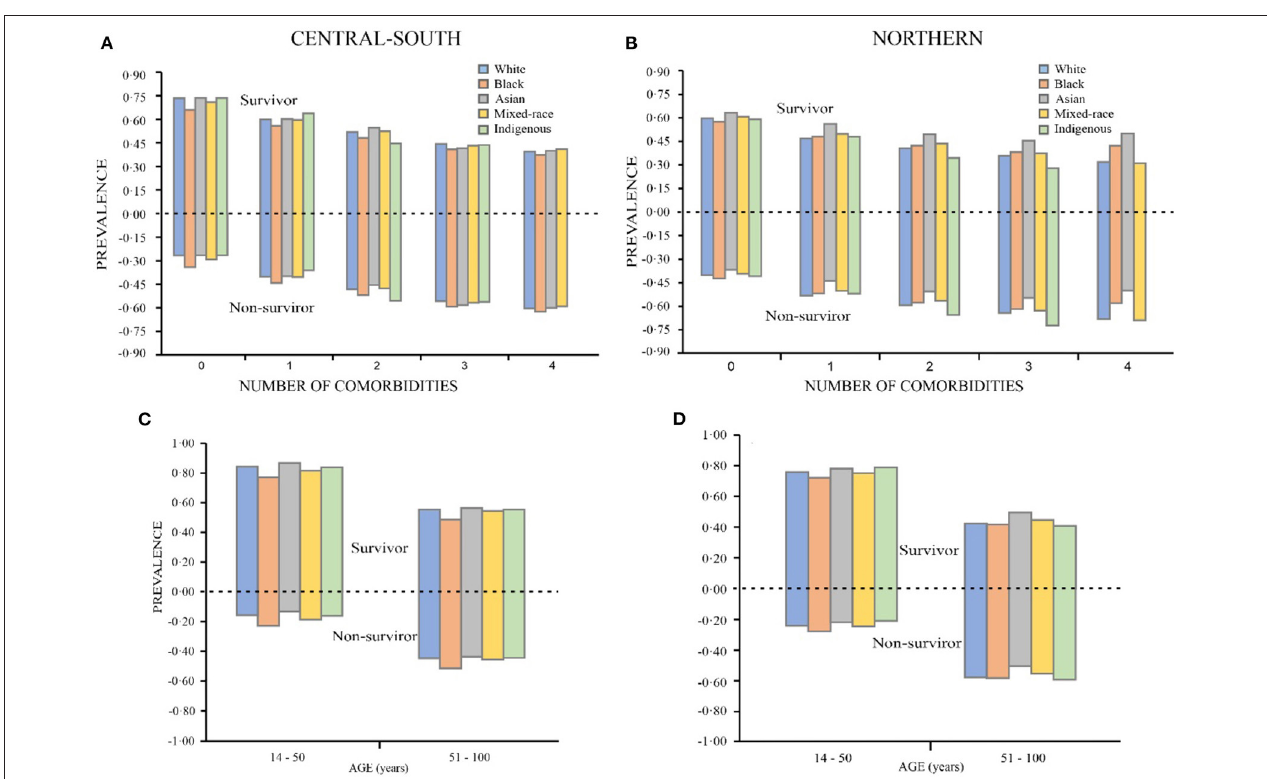
FIGURE 3 | Ethnicity distributions according to number of comorbidities (A,B) , age group (C,D) .